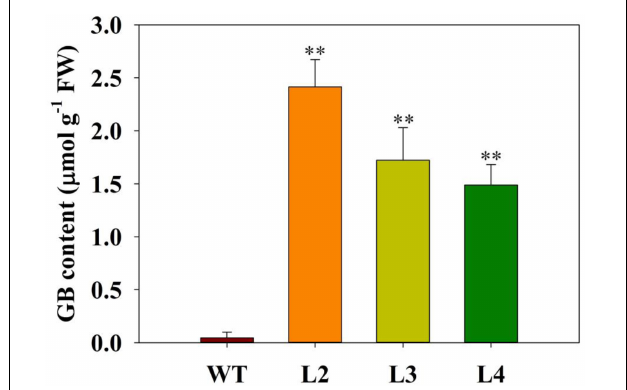
FIGURE 1 | Levels of glycine betaine (GB) in the leaves of wild-type (WT) plants and three codA -transformed tomato lines (L2, L3, and L4). Plants were treated under normal or low-phosphate stress conditions for 15 days. Values represent the means ± SD of four replicates. Asterisks indicate significant differences compared with WT plants (Student’s t -test). FW, fresh weight; ∗ P < 0.05; ∗∗ P <